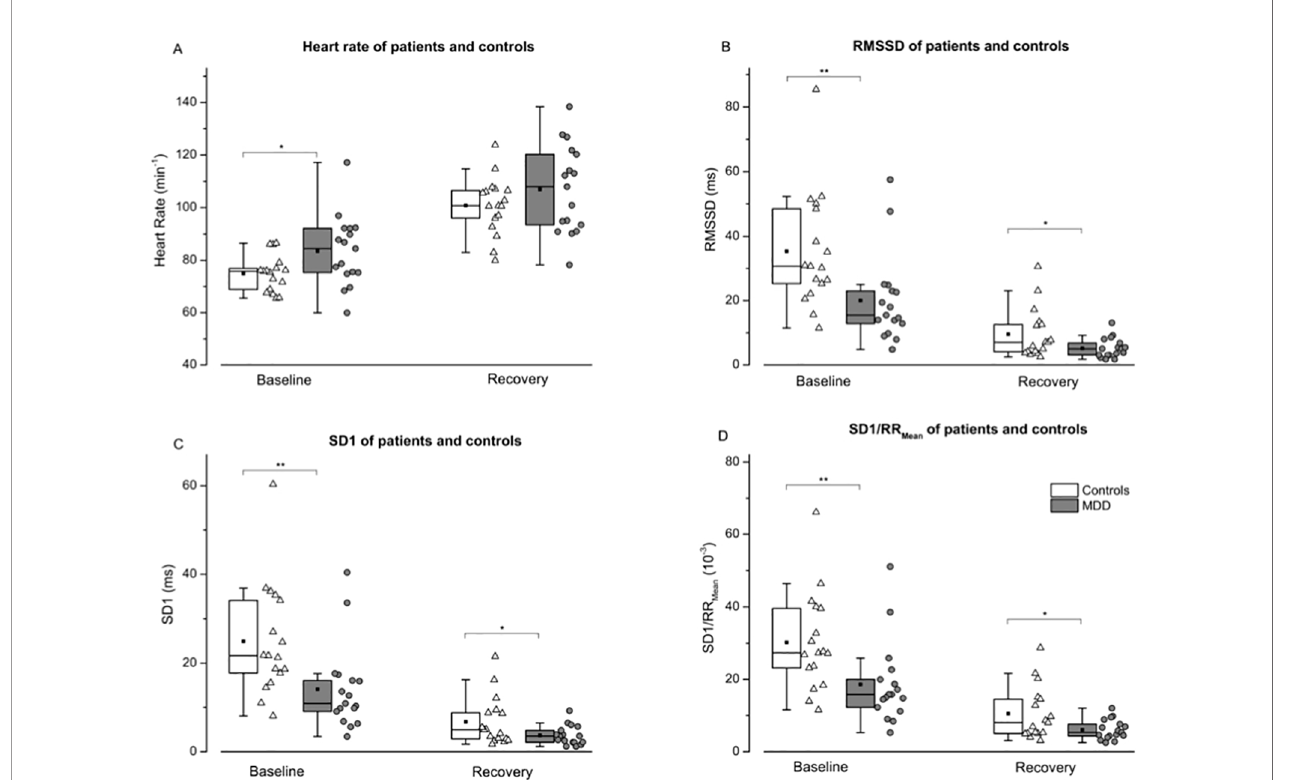
FIGURE 3 | Heart rate (A) , root mean of squared successive difference — RMSSD (B) , instantaneous variability — SD1 (C) , and SD1 normalized by mean RR — SD1/ RR Mean (D) are shown for controls (white boxes resp. triangles) and patients (grey boxes resp. points) before and 10 min after a maximal incremental exercise task. An independent two-tailed t test was calculated to compare patients and controls for descriptive analysis. While differences between heart rate were only shown at rest (A), reduced variability (B, C and D) were evident before and after exercise. Boxes indicate data between the 25th and 75th percentile with the horizontal bar re fl ecting the median ( ▪ = mean; – = 1.5 x interquartile range). Signi fi cant differences of pair-wise comparisons are indicated: *P < 0.05; **P <